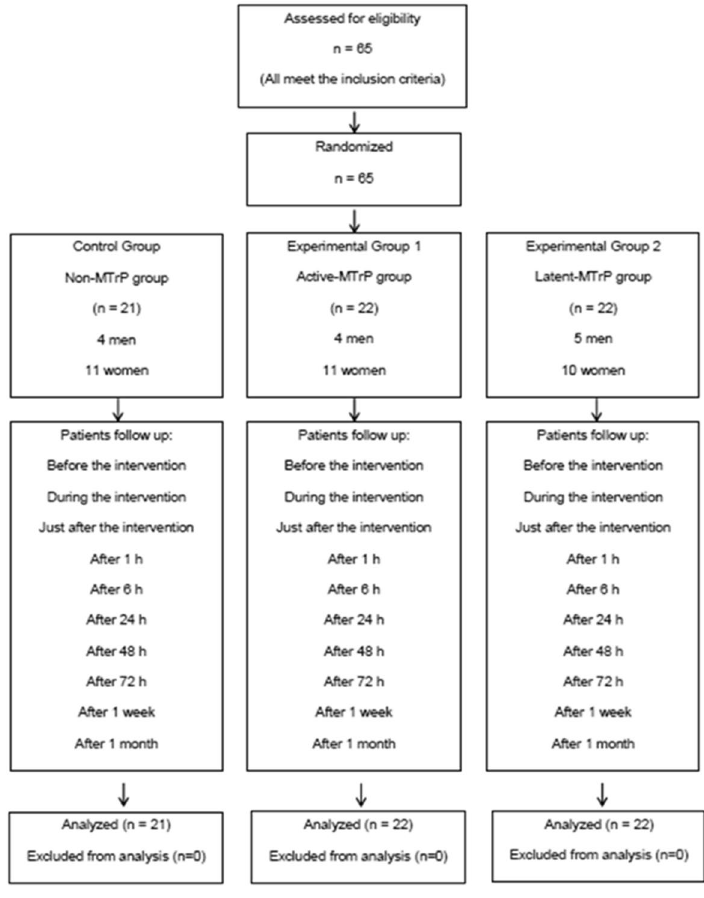
Figure 1. Flow diagram.